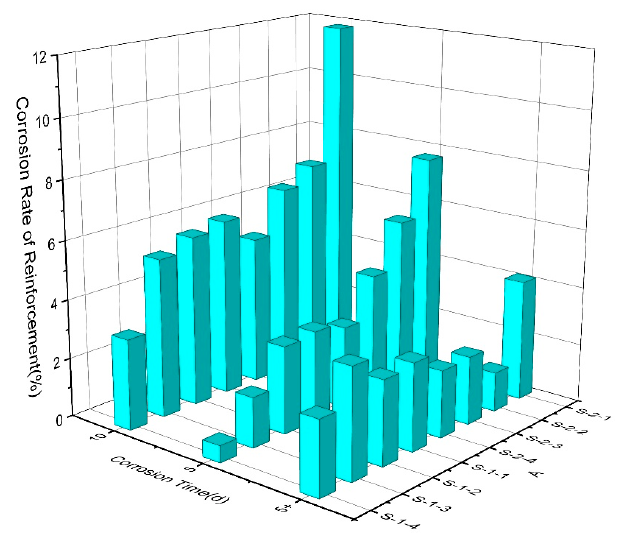
Figure 12. Reinforcement concrete mass loss rate at various levels.